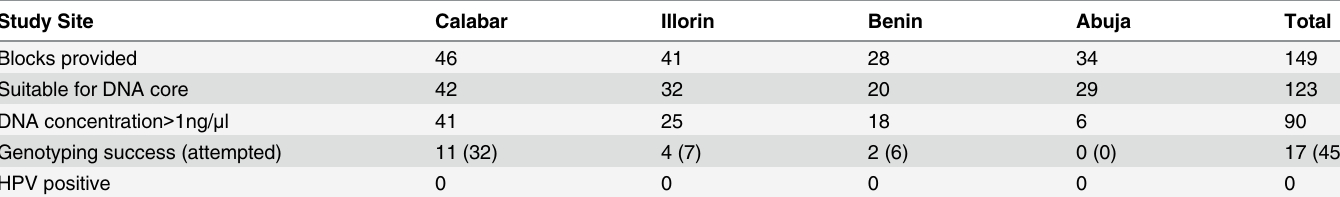
Table 2. Outcomes of Molecular Analysis.